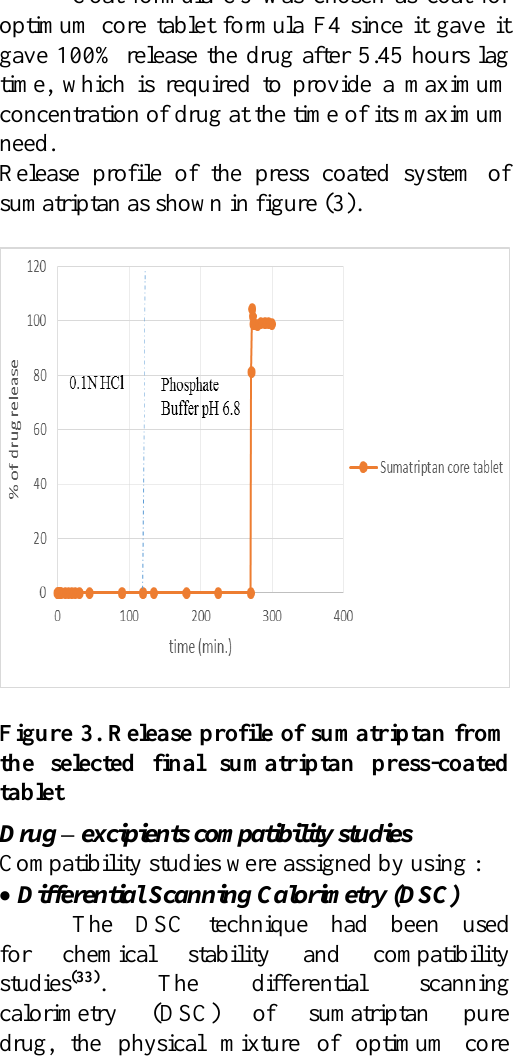
Table 7. Lag time of dissolution for different coating formulas of sumatriptan press-coated